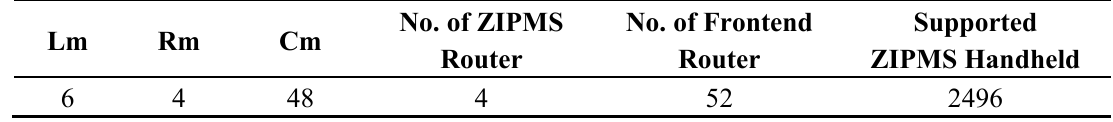
Table 4. Network configurations for the studied